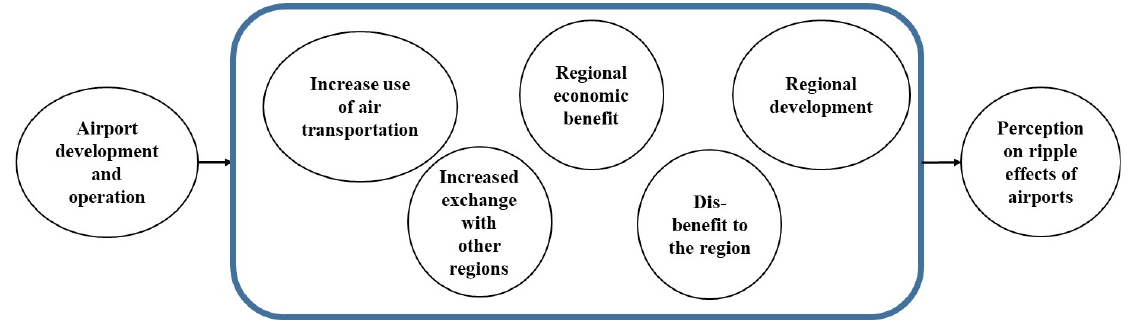
Figure 1. The concept model for the perception on the ripple effects of airports on the region. An initial structural equation that included all survey questions was constructed.